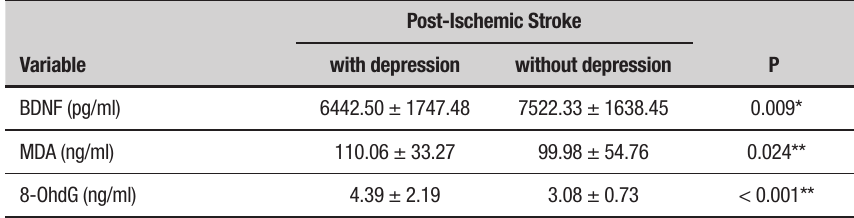
Table 2. Comparison of BDNF, MDA and 8-OhdG levels in the two groups.